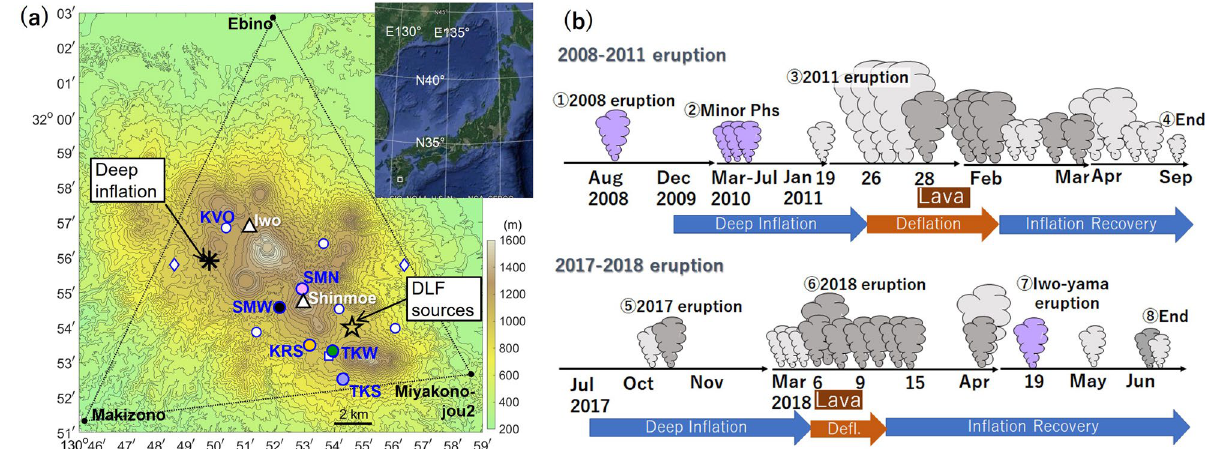
Figure 1. Overview of the monitoring system and the eruption sequences at Shinmoe-dake. ( a ) A map of Kirishima volcanic group in southwestern Japan (the white square in the inset: Goole Earth, Data SIO. NOAA.U.S. Navy NGA GEBCO). The white triangles indicate Shinmoe-dake and Iwo-yama. The colored circles are seismic stations used in this study, and white markers show other seismic stations. The vertices of the black triangle are the GEONET stations calculating the areal strain 43 , which represents the deep inflation beneath the asterisk 40 . The star indicates the epicenters of deep low-frequency earthquakes, whose rate correlated with the inflation at the asterisk 44 . ( b ) A schematic representation of Shinmoe-dake eruption sequences 34,41 . ① The August 2008 phreatic eruption, ② minor phreatic eruptions, ③ the main phase of the 2011 eruption, ④ the end of the 2011 eruption, ⑤ the 2017 eruption, ⑥ the main phase of the 2018 eruption, ⑦ the April 2018 phreatic eruption at Iwo-yama, and ⑧ the end of the 2018 eruption. The purple, light-gray, and dark-gray clouds indicate phreatic, ash-forming, and vulcanian eruptions,